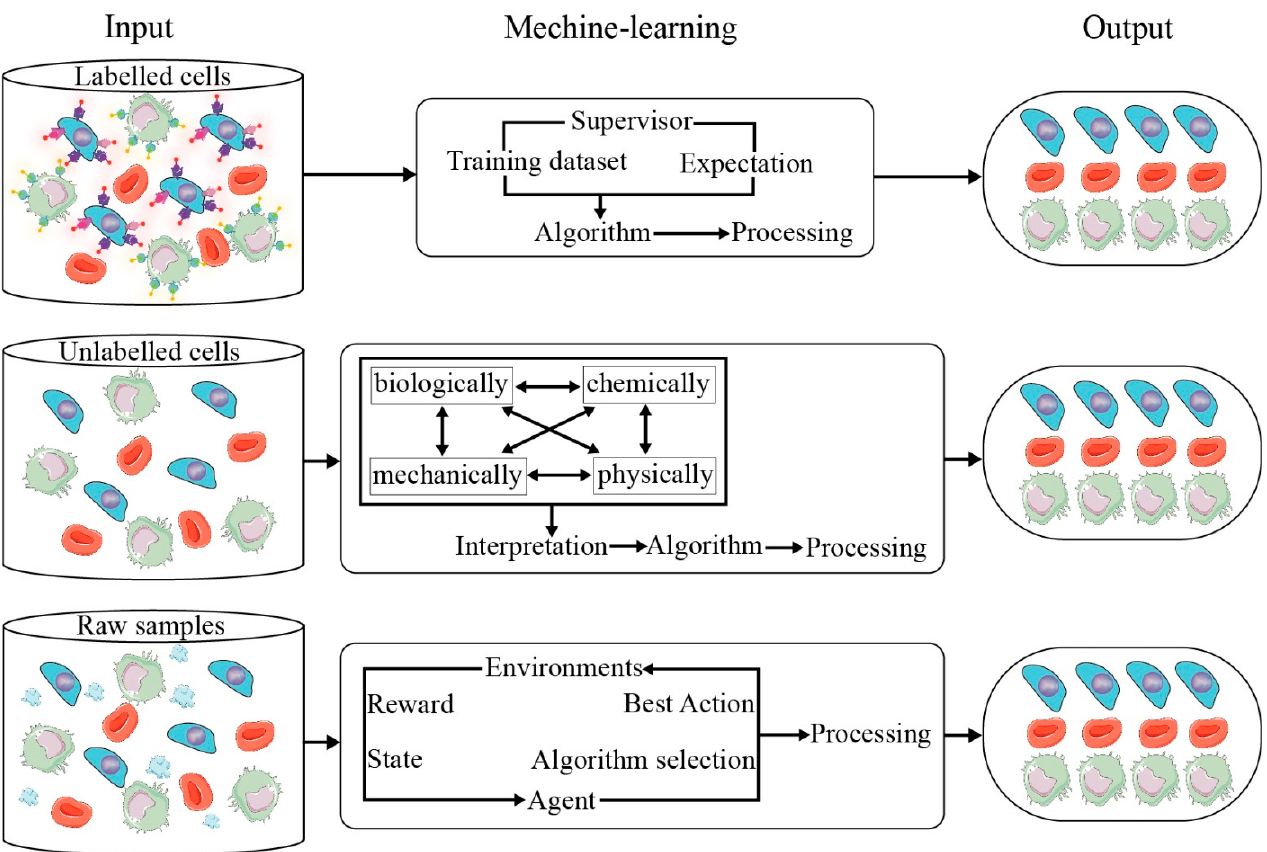
Figure 3. Different types of machine learning are applied in cell classification in microfluidic plat- forms.